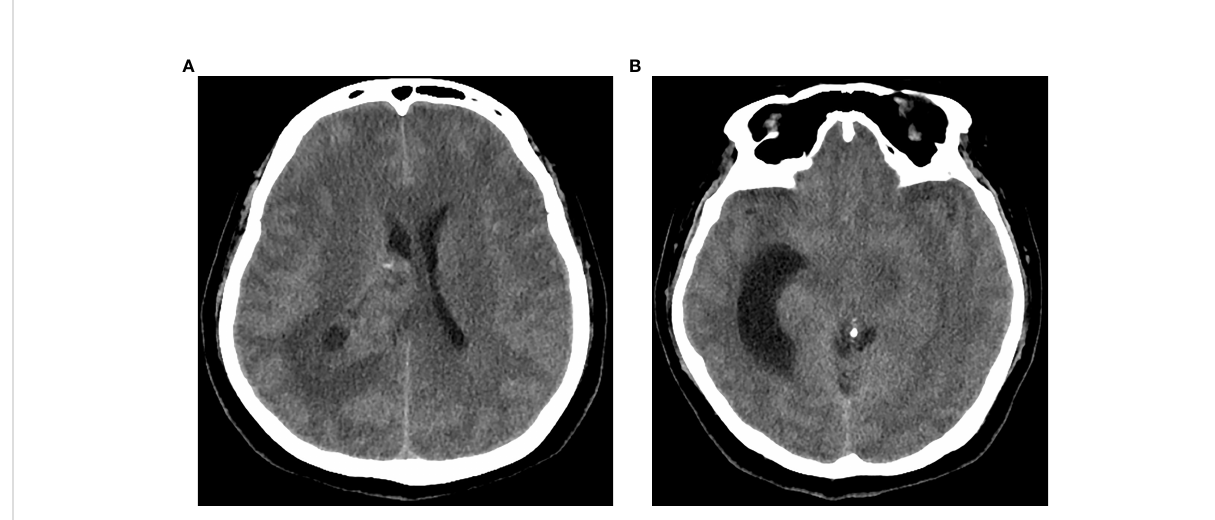
FIGURE 1 CT of the head showed a right intraventricular solid and cystic mass lesion (A) with trapped temporal horn and periventricular edema (B)